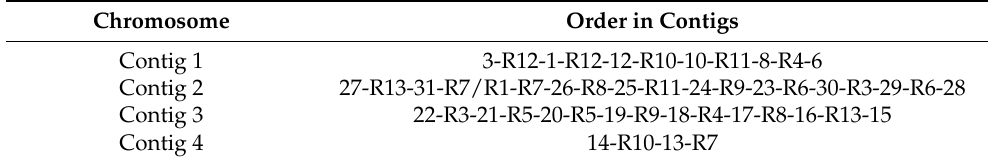
Table 4. The segments and repeats are contained in four